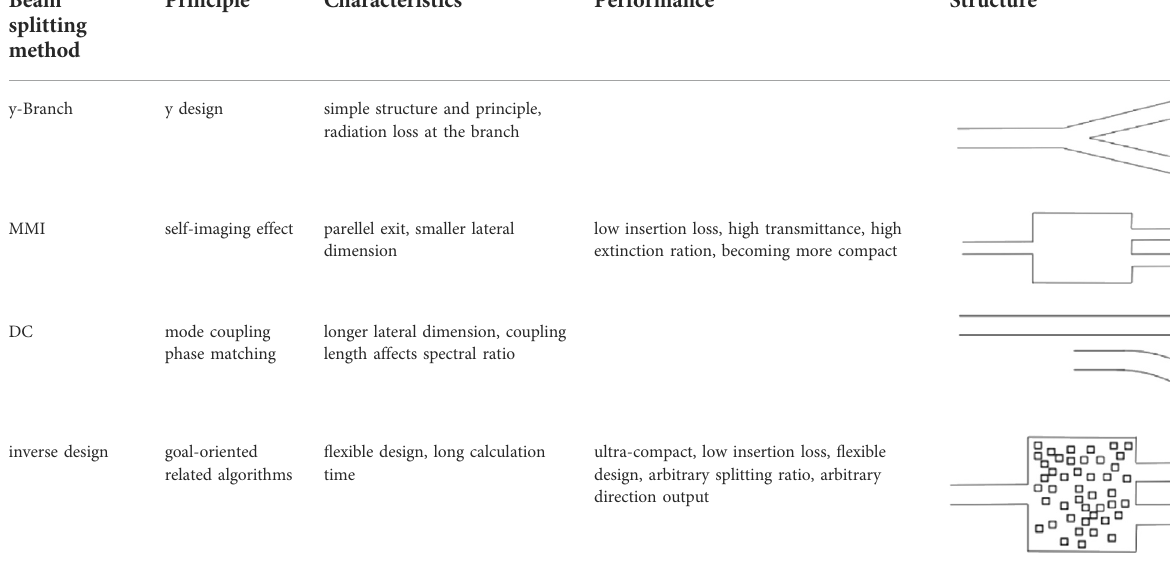
TABLE 1 Comparison of four main beam splitting